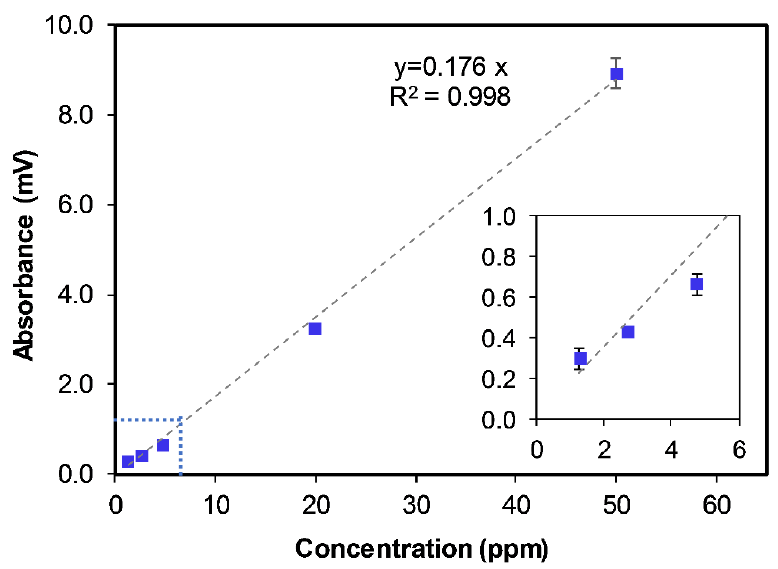
Figure 6. Calibration curve representing the absorbance vs. the gaseous toluene concentration in the range 1.5–50 ppm. The error bars represent the standard deviation of absorbance for three experi-